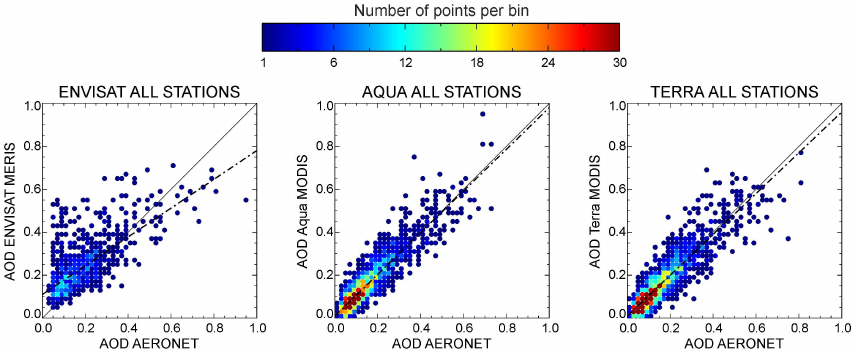
Fig. 5. Same as Fig. 3 for ENVISAT MERIS, Aqua MODIS, and Terra MODIS showing the summary of all AERONET